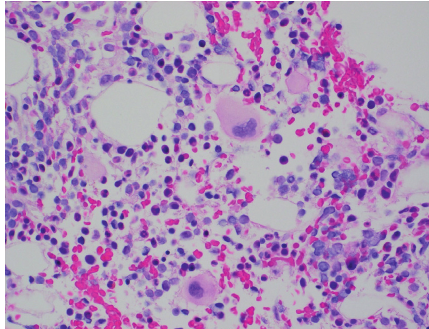
Figure 1: Hematoxylin and eosin (H&E) section of the hypo- cellular bone marrow with no definitive infiltration by lymphoma.